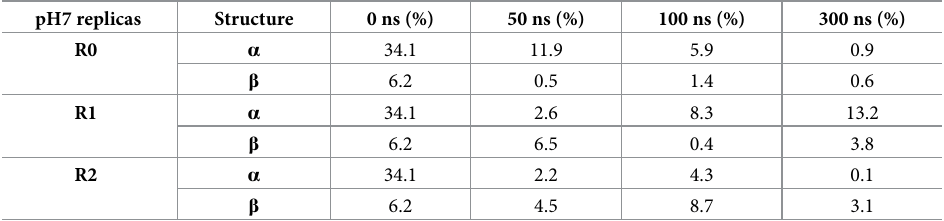
Table 2. The percentage of alpha-helix and beta-strand secondary structures for all simulation replicas at pH 7. pH7